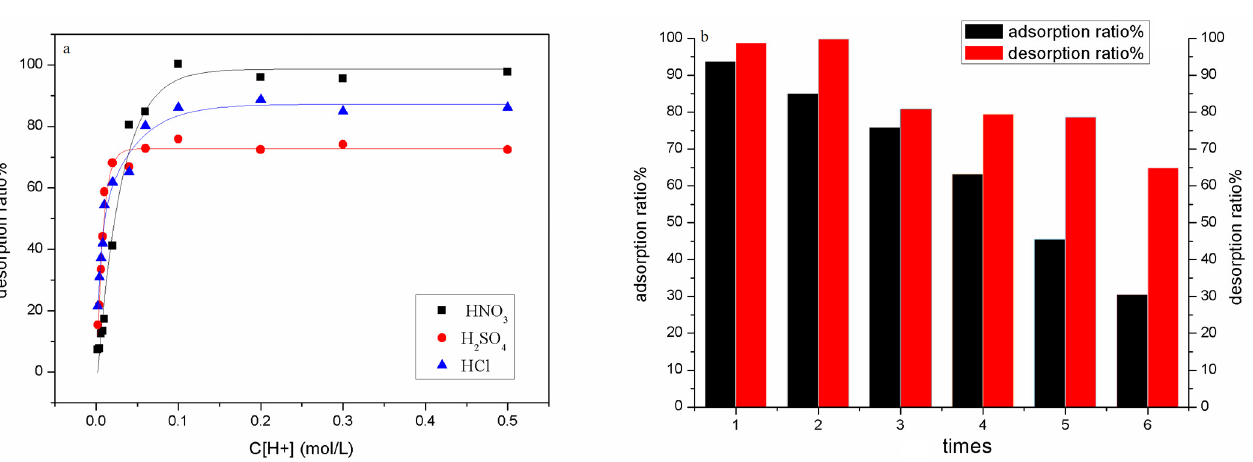
Figure 10. Desorption capacity and reuse capacity ( a : Desorption capacity of AO-CELL under different acidic conditions; b : the adsorption regeneration experiment of AO-CELL. Reuse experiment conditions: solid/liquid ratio = 0.08 g/L; C 0 [Th(IV)] = 19.00 ± 0.10 mg/L; [H + ] = 0.06 mol/L; T = 298.15 ± 1.00 K; t = 0.5 h.)